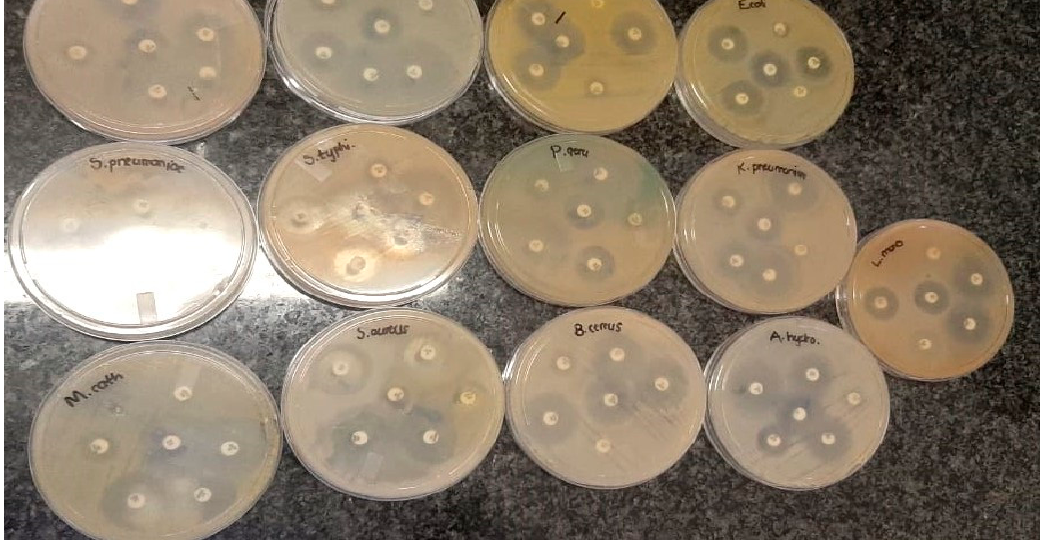
Figure 10. Antibiogram tests showing zones of inhibition against pathogenic strains. Table 2. Antibiogram resistance profiles of the isolates.